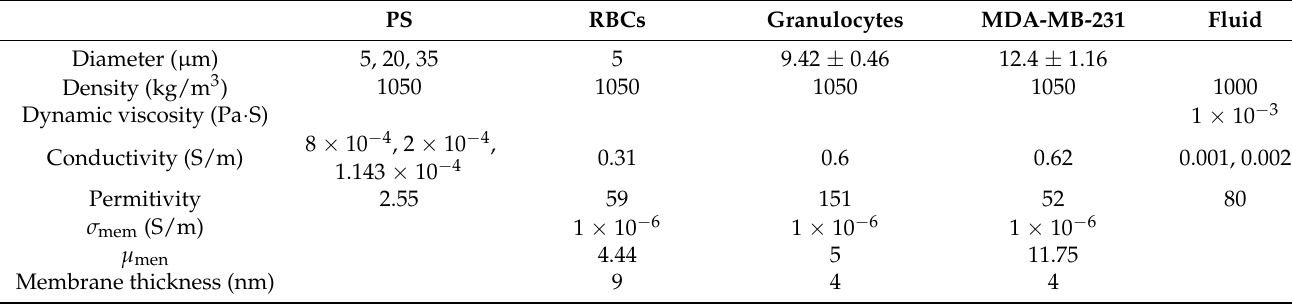
Table A1. Summary of the material properties used in the